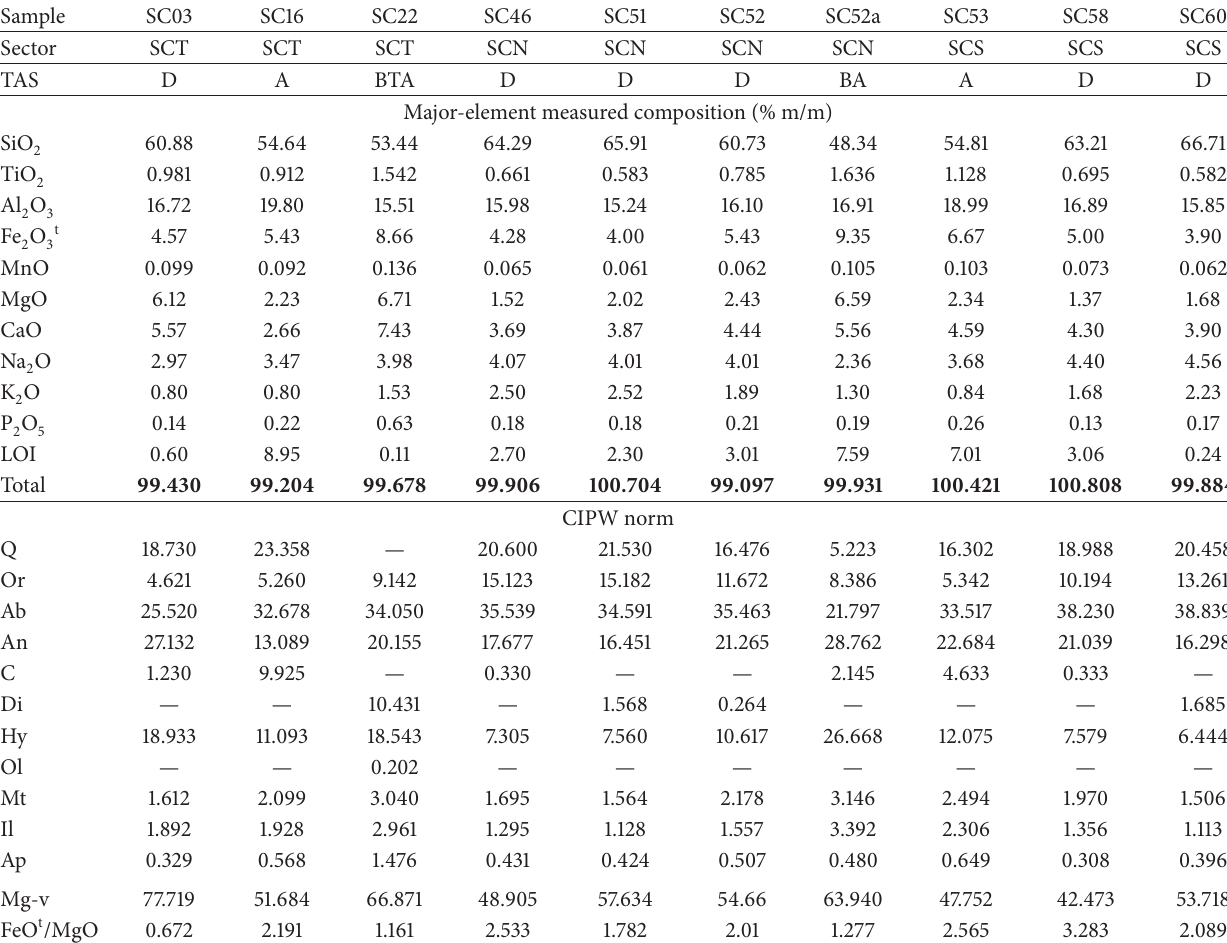
Table 2: Major element composition (% m/m) and CIPW norm for the volcanic rocks from the Sierra de las Cruces range a .